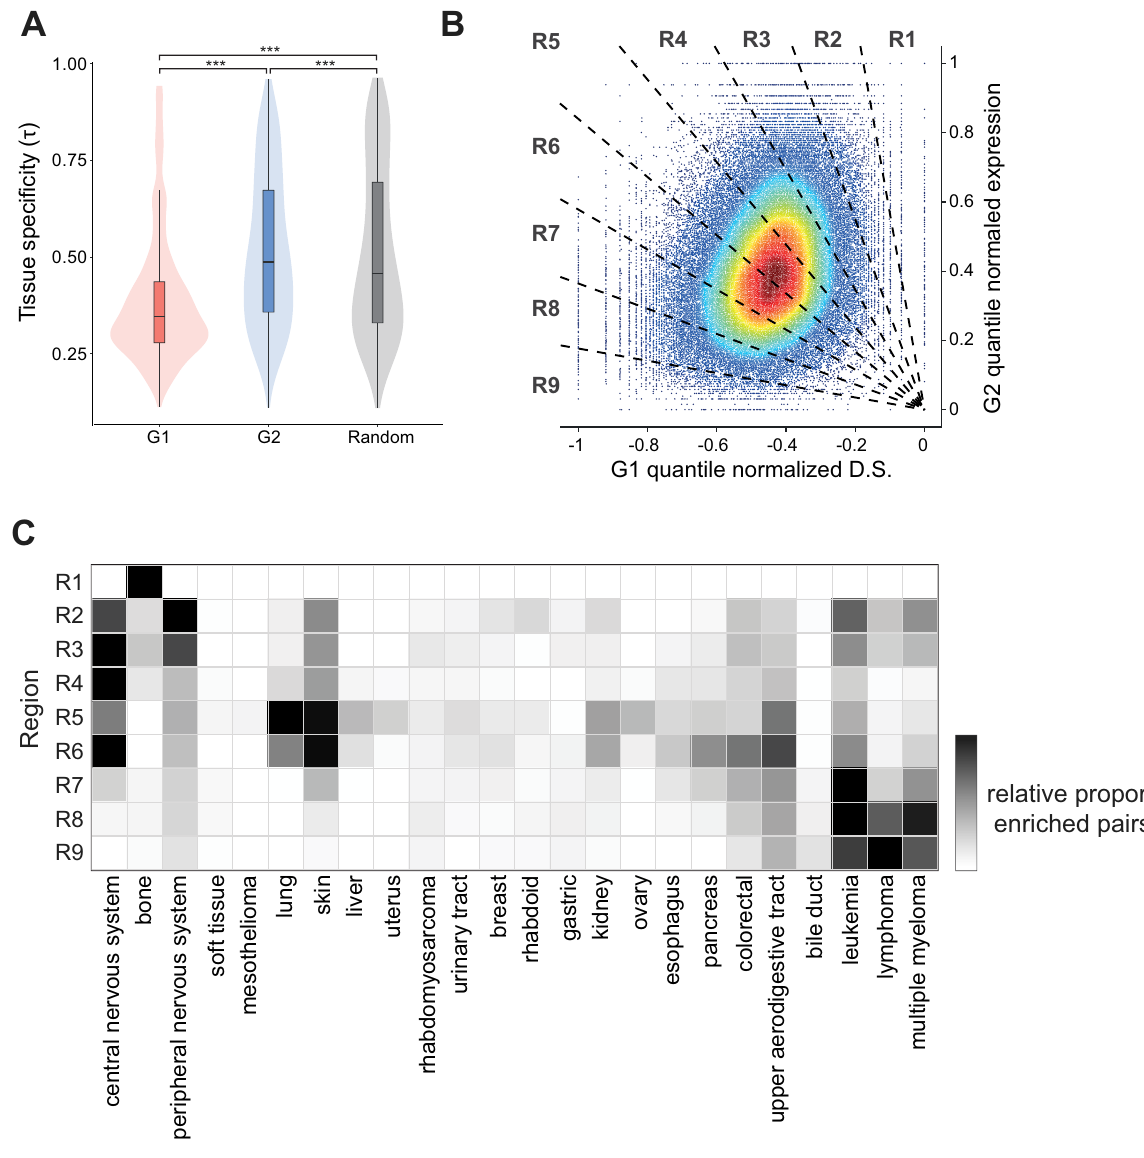
Figure 4. Tissue specificity of CEBU. (A) Tissue specificity ( τ ) of G1 and G2 pairs. τ was calculated for G1 and G2 from high C-score gene pairs. Statistical significance was assessed by paired- t test. ( B ) Density plot showing overlay of 100,000 randomly selected high C-score gene pairs. D.S. (G1s) and expression (G2s) were normalized to be between − 1 and 0 or 0 and 1, respectively. Each dot represents a cell line based on its normalized D.S. for G1 and normalized expression for G2. Color gradient indicates low to high density as blue to dark red, respectively. The normalized C-score plot was divided equally into nine regions (R1–R9) by radiating lines out from zero. ( C ) Tissue/cell-type specificity of each region (R1–R9) of the normalized C-score plot. The heatmap represent the relative percentage of statistically enriched gene pairs for the corresponding tissue/cell types. The heatmap is created by the Conditional Formatting function of (AUC) is significantly larger than random (Mann–Whitney U test with false discovery rate, FDR < 0.1, Fig. 5B). Furthermore, predictive performance increased for higher C-score cutoffs, as indicated by their increasing AUC (Fig. 5B). Moreover, the buffering capacity is quantitatively correlated with the strength of genetic interaction. We observed a negative correlation between C-score-derived buffering capacities and experimentally validated genetic interactions (C-score cutoff = 0.25, correlation = − 0.231, p -value = 0.034, FDR = 0.081, Supplementary Fig. S8A), and this correlation is stronger for higher C-score cutoffs (Supplementary Fig. S8B). Even though this correlation coefficient of − 0.231 is not strong (although it is statistically significant), the intrinsic vari- ability associated with collating experimental results from four independent studies must be considered a con- tributory factor to weakening that correlation 19,32,43,44 . Moreover, predictions of genetic interactions based on CEBU buffering capacity are robust even when different thresholds for calculating buffering capacity are applied (“Methods” and Supplementary Fig. S8C). Accordingly, CEBU buffering capacity may be used to infer genetic